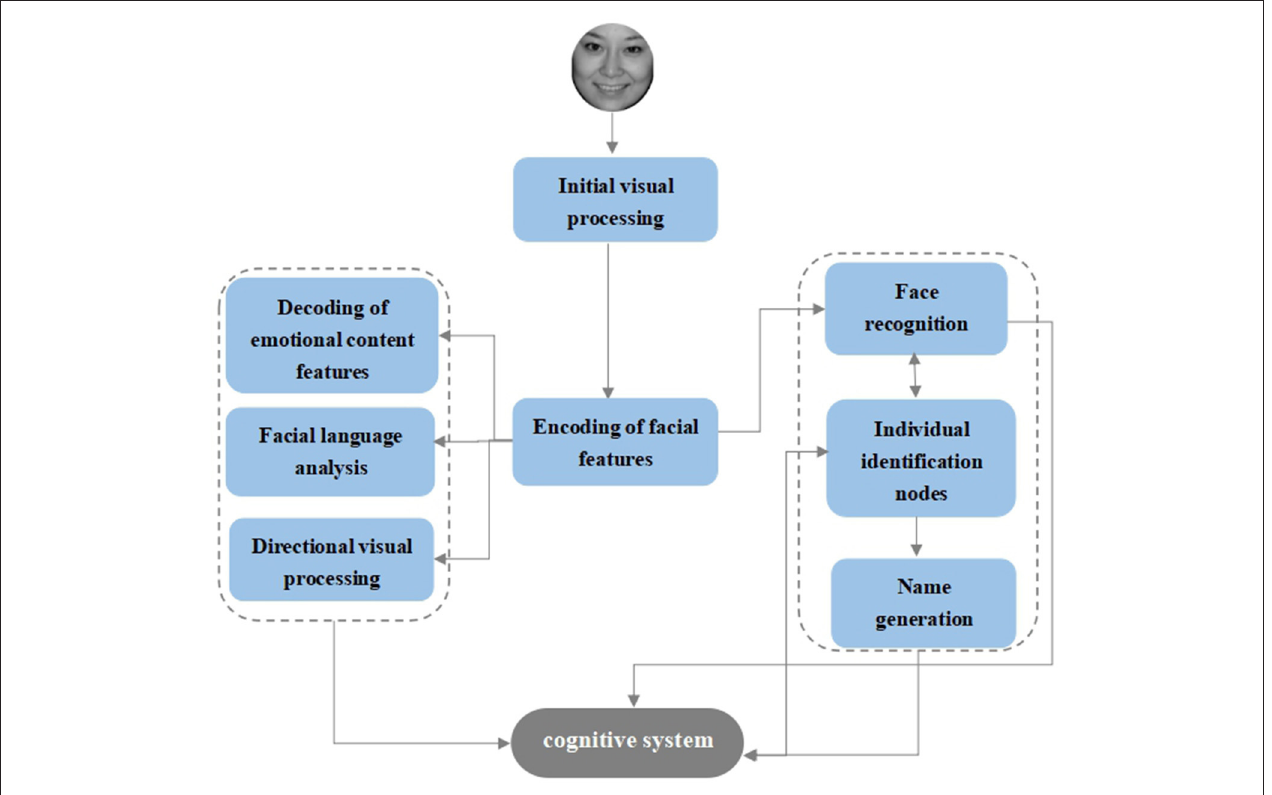
FIGURE 2 | Bruce and Young’s Facial Recognition